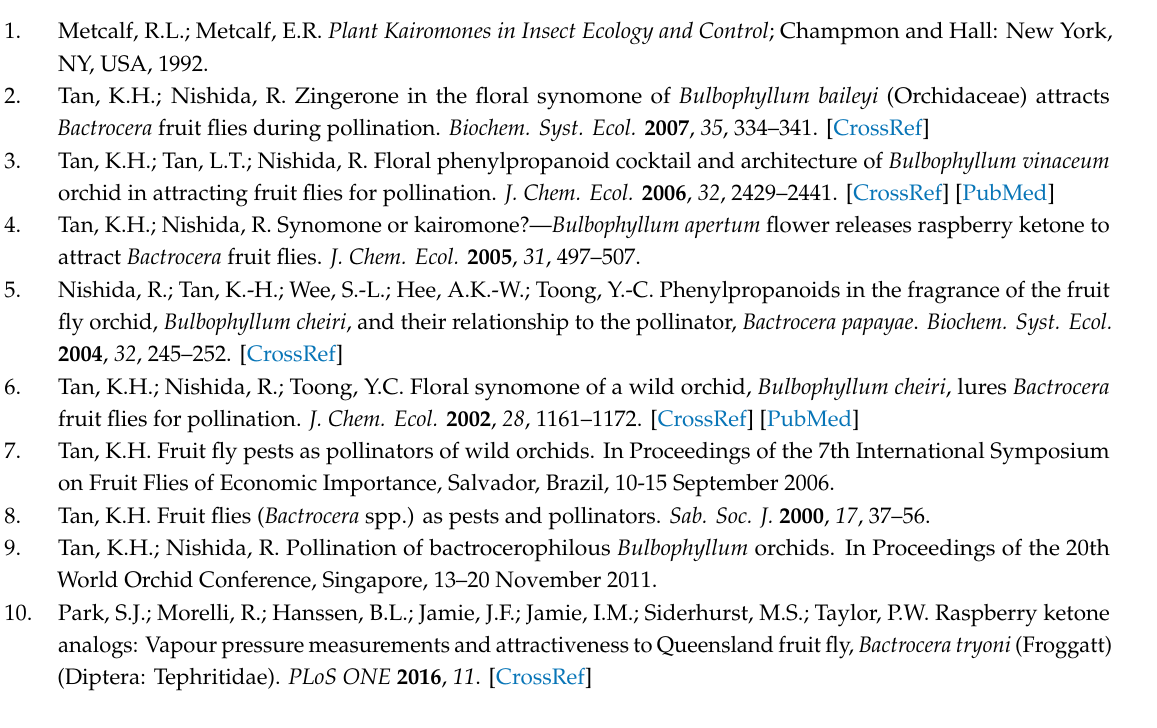
Supplementary Materials: The following are available online, Figure S1. Mass spectrum and diagnostic ions of 3-ethyl-2,3-dihydro- 4H-pyran-4-one; Figure S2. Mass spectrum and diagnostic ions of 1-(4-methyl- 1,3-dioxolan-2-yl)pentan-3-one, Figure S3. Residual plots of raspberry ketone in the inner coronal filament, zingerone in both filaments, and cuelure in the outer coronal filament from exponential decay fitting, Figure S4. Flower of P. maliformis and B. jarvisi males